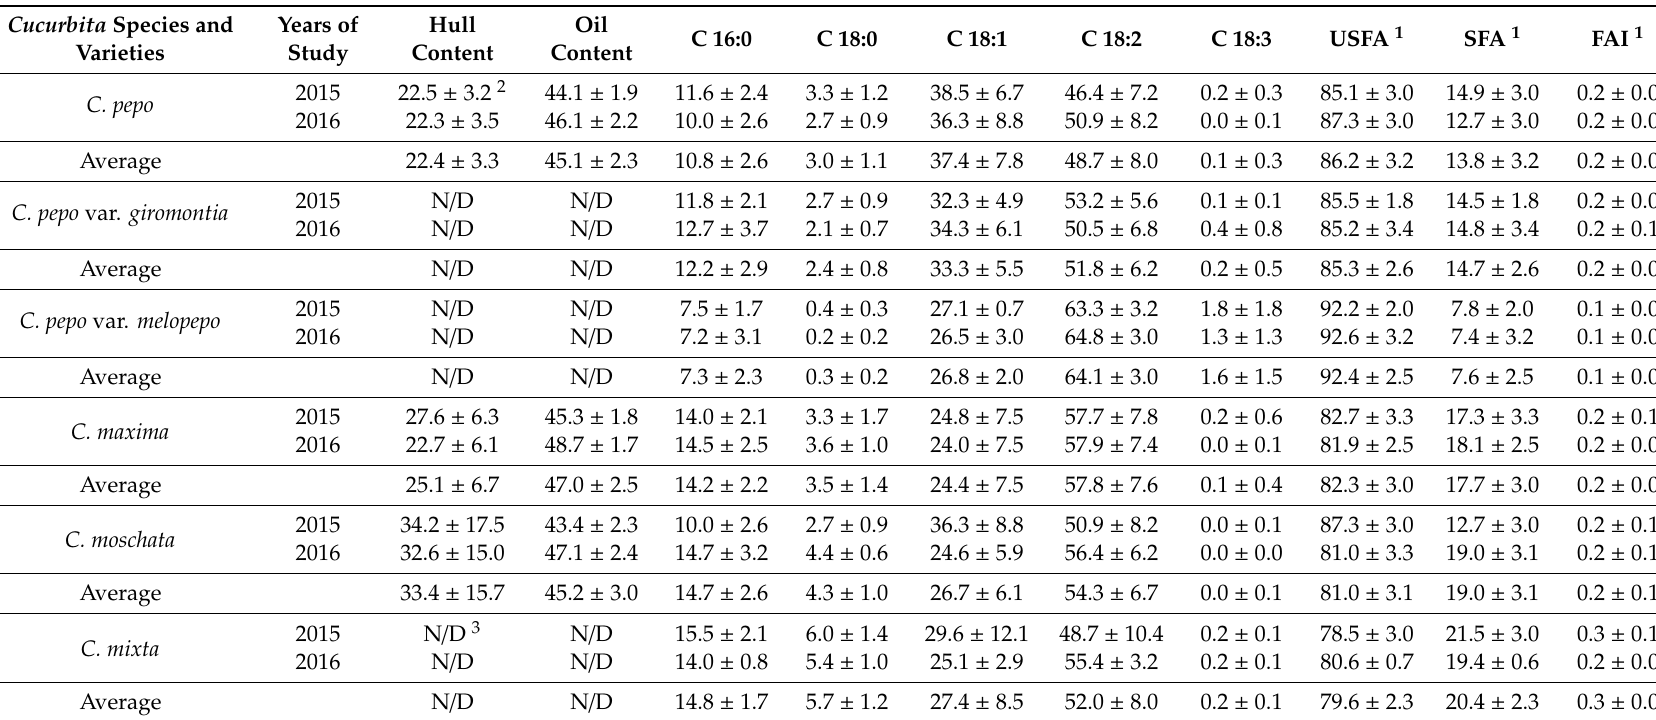
Table 2. Average values of hull, oil content and fatty acids profile 1 (percentage, mean values ± SD 2 ) in seeds of Cucurbita L. species from the VIR collection. Cucurbita Species and